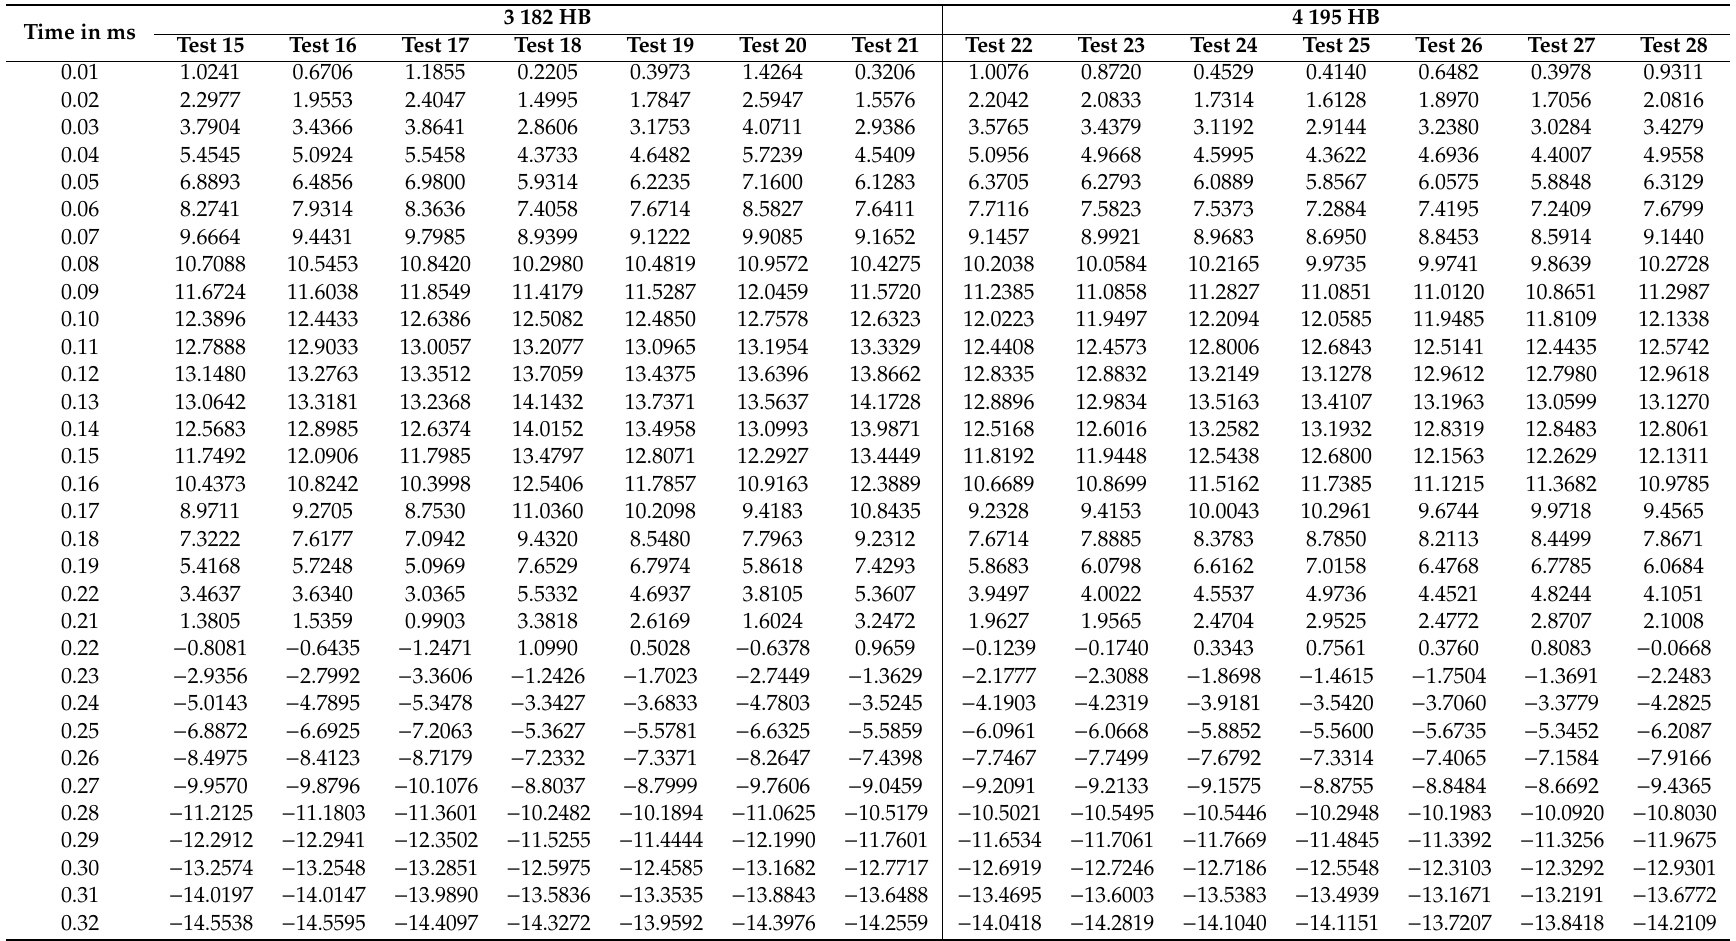
Table A2. Accelerations measured for tests from 15 to